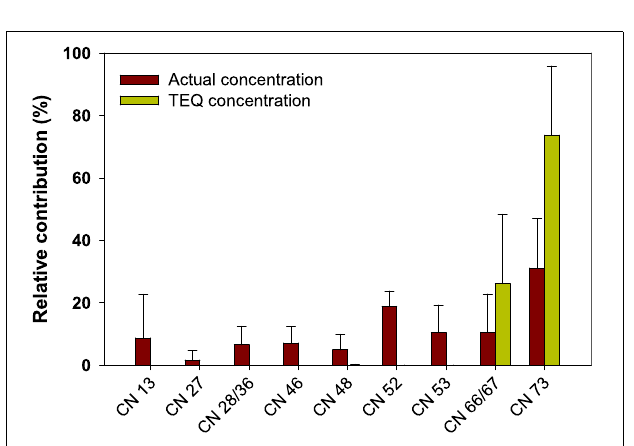
FIGURE 3 | Average relative contribution of PCN congeners for actual and TEQ concentrations in sediment from Ulsan and Onsan Bays and their inflowing rivers and streams, Korea. Vertical bars represent standard